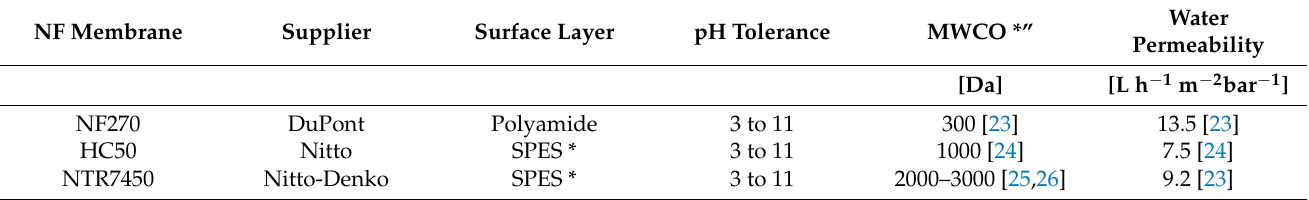
Table 1. NF membrane